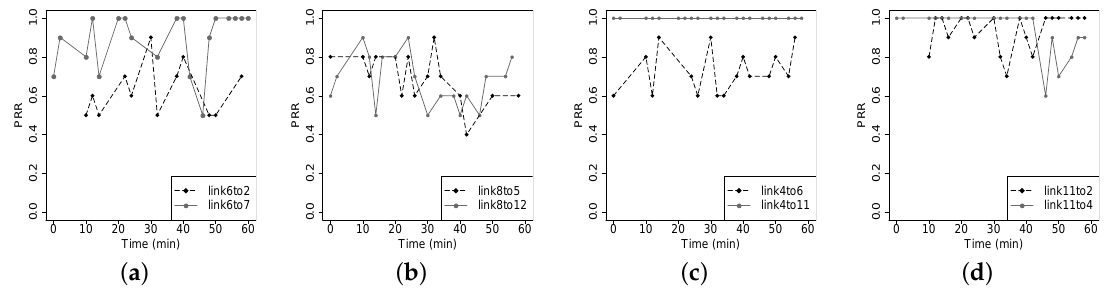
Figure 18. Demo of the link correlation measured in the Jiufeng experiment. ( a ) Correlation = 0.63; ( b ) Correlation = 0.28; ( c ) Correlation = 0; ( d ) Correlation = −